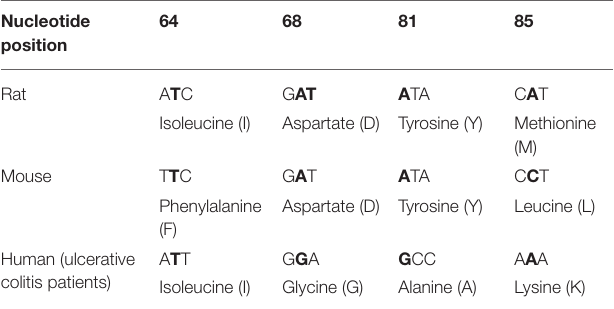
TABLE 1 | Nucleotide changes observed in human SFB gene from the terminal ileum of 35–70-year-old males and females with ulcerative colitis (64) compared to codons from the SFB genes of healthy rat and mice.